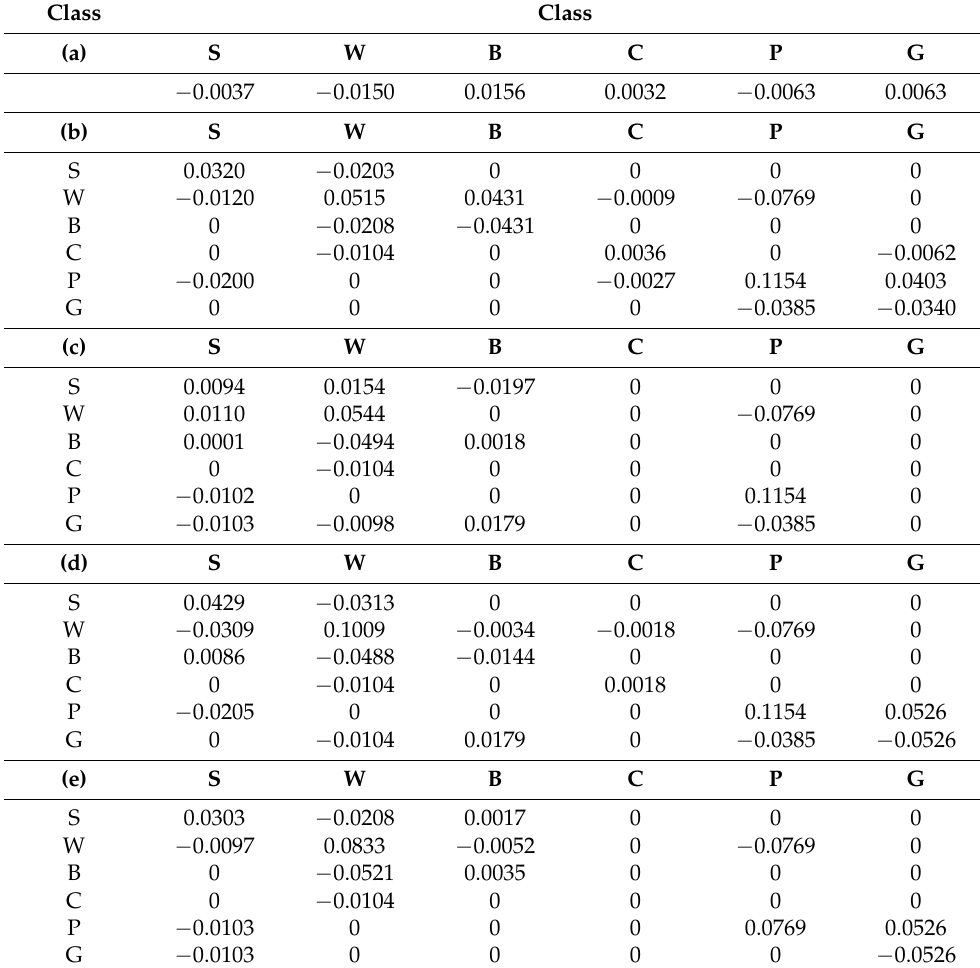
Table 3. Difference between the latent class and actual value determined with ground data (calculated as latent estimate—actual). ( a ) probability of class occurrence, ( b ) conditional probabilities from the discriminant analysis, ( c ) conditional probabilities from the decision tree, ( d ) conditional probabilities from the neural network and ( e ) conditional probabilities from the support vector